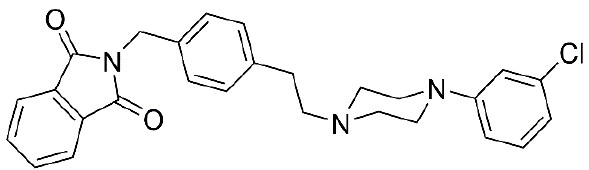
Figure 1: Molecular structure of compound 1